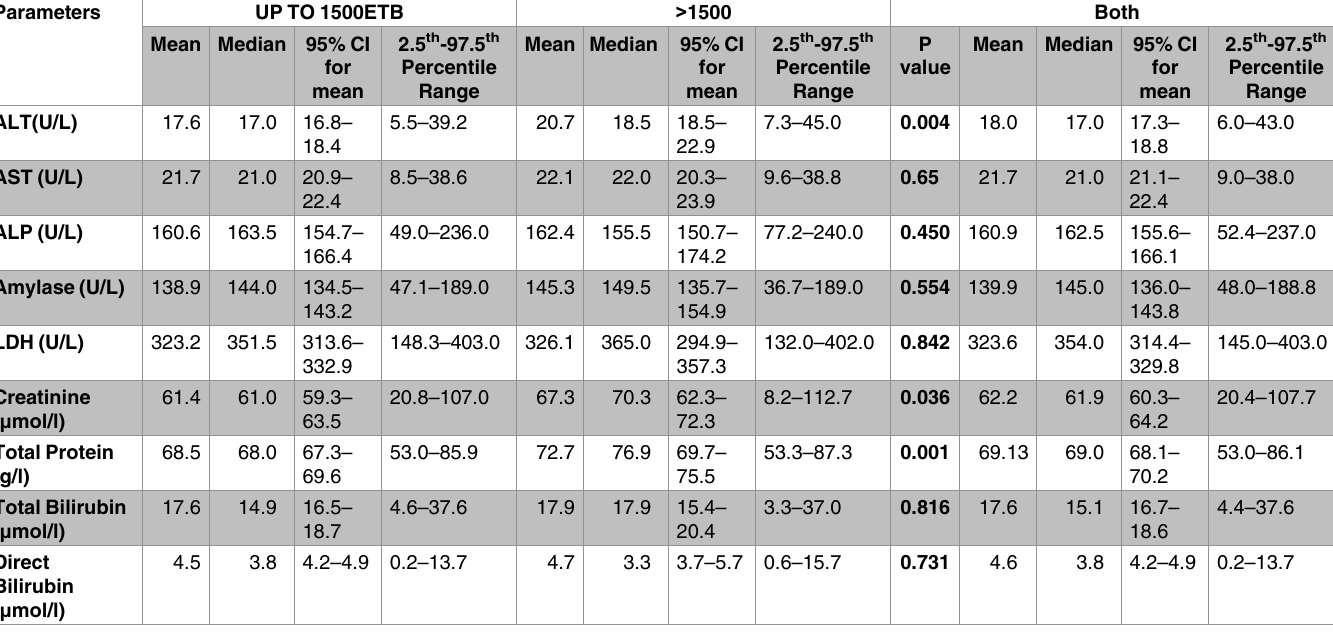
Table 5. Mean, median, 95% CI for mean and 2.5 th -97.5 th percentile of clinical chemistry referencevalues in relation to monthly income of healthy adults in adults in Gojjam, Zones, AmahraNational Regional State, Northwest Ethiopia.